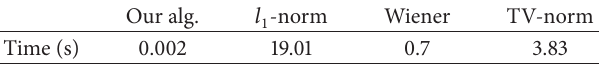
Table 2: Execution time evaluation for tested algorithms. Our alg.